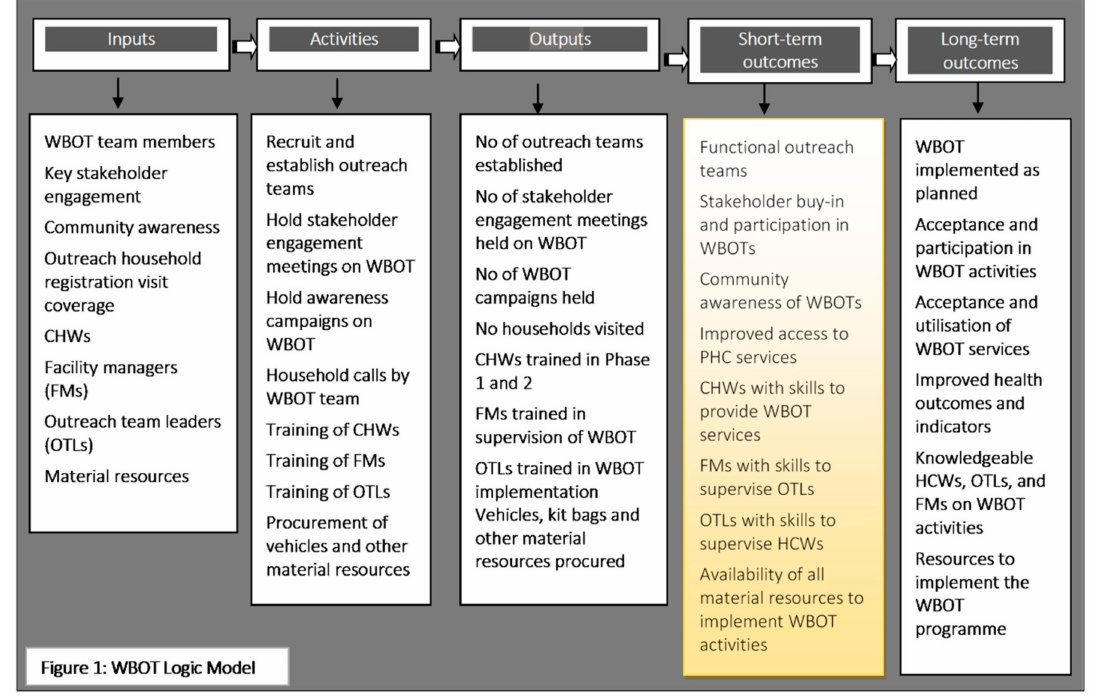
Figure 1. Ward-based outreach team (WBOT) logic